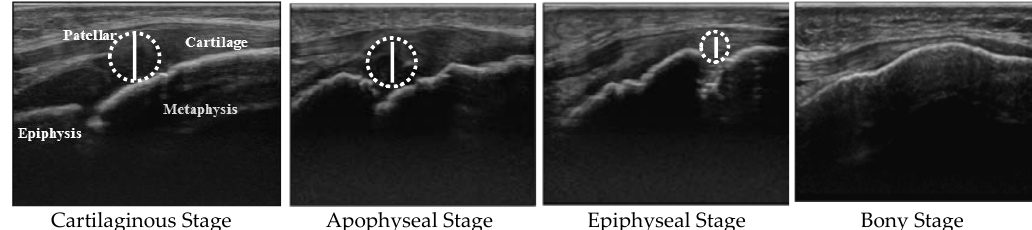
Figure 1. Measurement of cartilage thickness at the tibial tuberosity for each maturity stage. The cartilage thickness at the tibial tuberosity is estimated by the largest diameter of the true circle drawn in the space of the apophyseal cartilage.